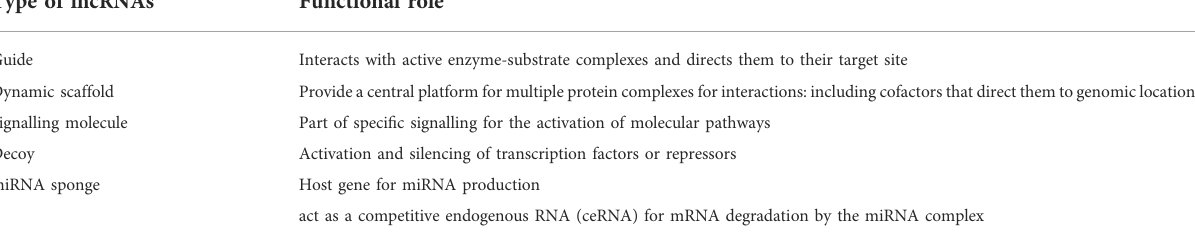
TABLE 2 Classi fi cation of long noncoding RNAs based on their physiological cellular